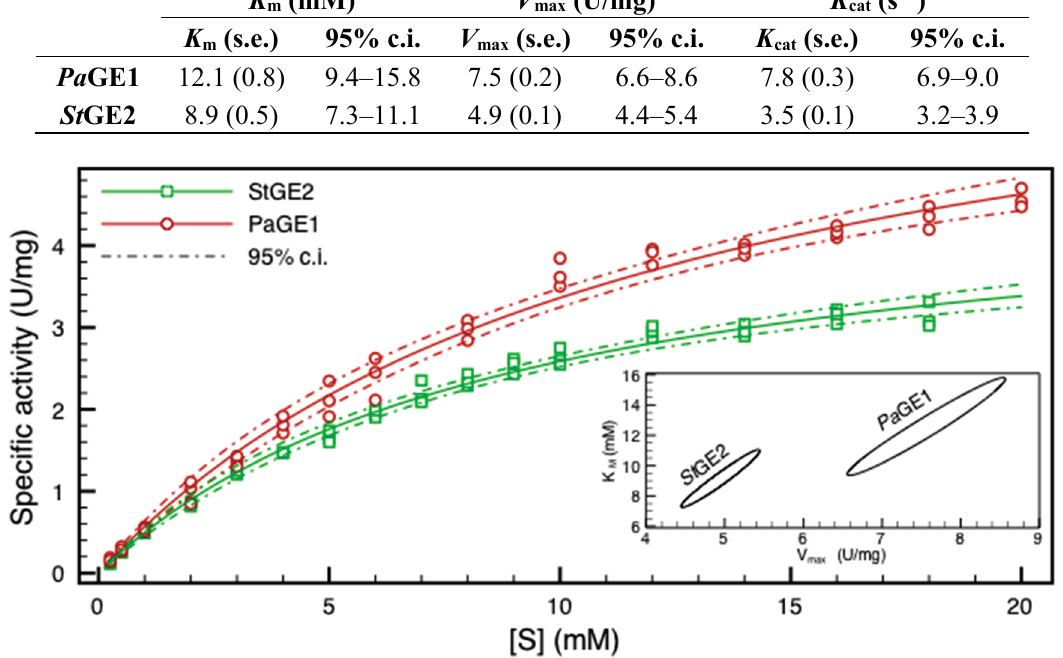
Table 2. The kinetic parameters of Pa GE1 and St GE2 on BnGlcA as determined in the HPLC assay. The standard errors were calculated from the covariance matrix of the parameter fitting and the 95% confidence intervals were estimated as described in the Experimental Section.